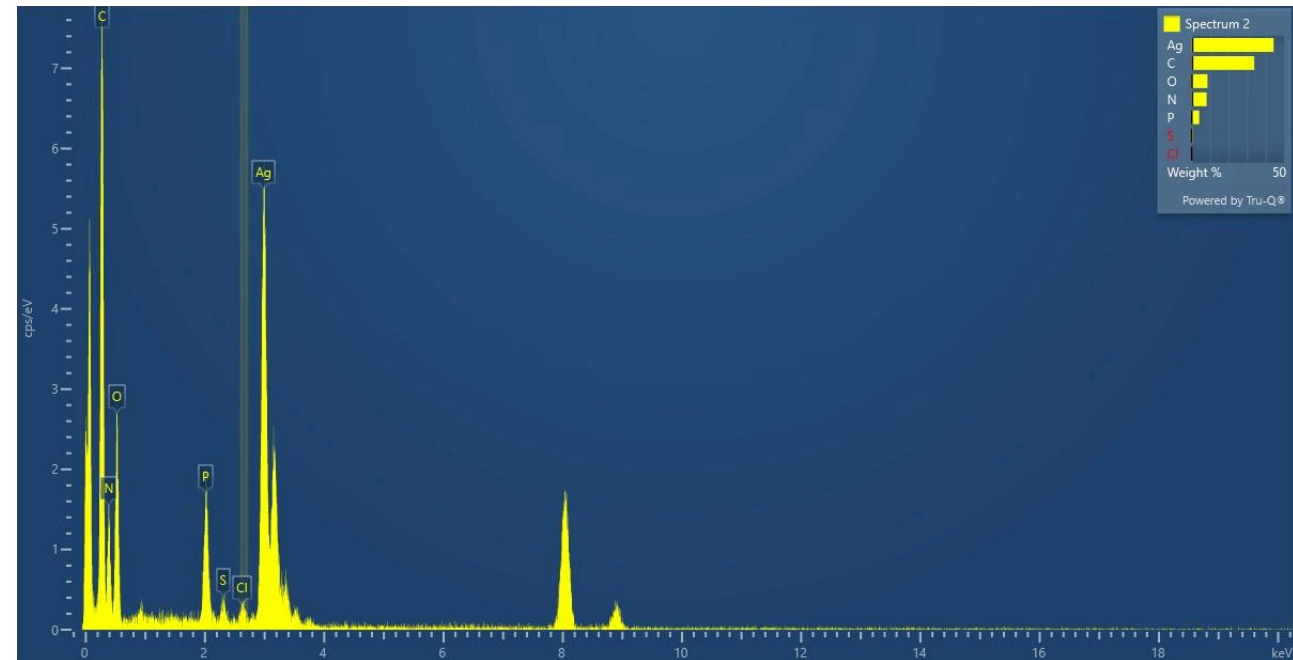
Figure 4. Energy dispersive spectroscopy (EDS). X-ray spectrum of b-AgNP (8M urea × 2) indicating Ag, C, O, N, P along with small amounts of P, CL.